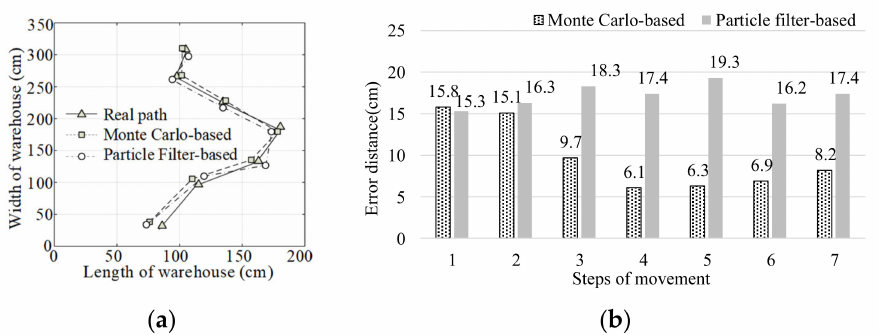
Figure 10. Experimental positioning results ( a ) and positioning errors ( b ) when the two antenna footprints merge into